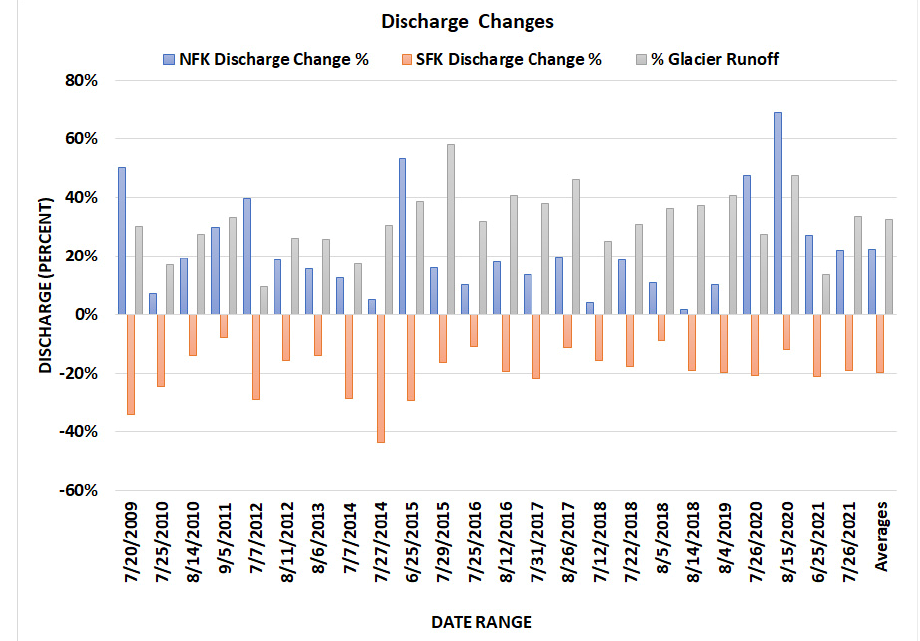
Figure 4. Change in discharge in the North Fork Nooksack (NFK) and South Fork Nooksack (SFK) during the 23 heat events. The percent of North Fork Nooksack discharge generated by glacier runoff is also indicated.